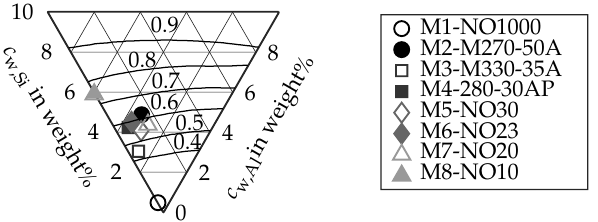
Figure 3. Theoretical values for the electric resistivity ρ el ( ϑ = 298K ) in Ω mm 2 /m based on the silicon and aluminum content (Source: Data from